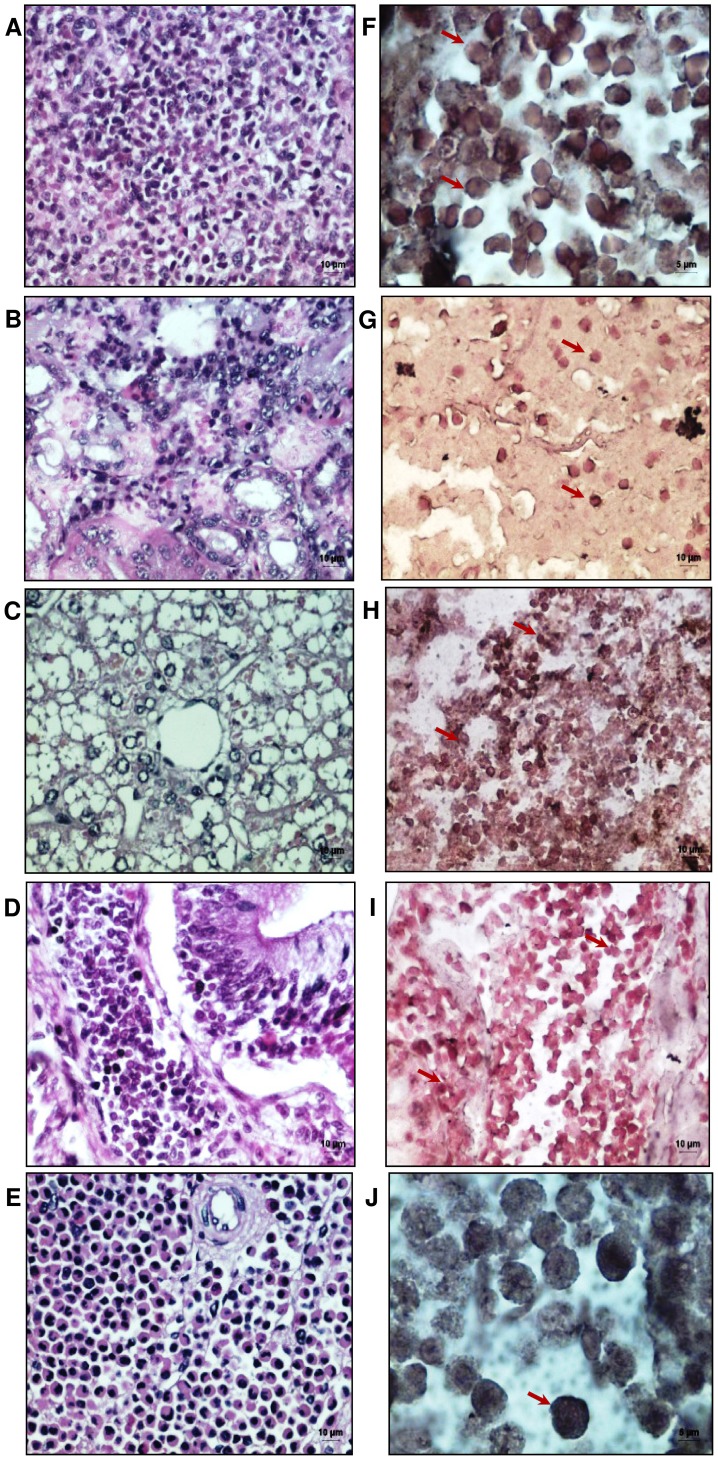
Localization of the shTLR3 by in-situ PCR in tissues sections of Chiloscyllium griseum spleen, kidney, liver, intestinal spiral valve and epigonal tissues.
A to E: H & E staining of the above tissue sections; F to J: In-situ PCR revealed positive signals (brown areas due to the DAB substrate) in all the tissue types examined for TLR3 mRNA that can be localized to lymphoid cell types with thin rim of cytoplasm G: the tubular epithelial cells in the kidney revealed the presence of shTLR3 mRNA.